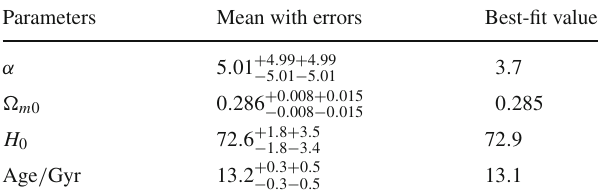
Table 2 This table shows the constraint results on the parameters of DE model with n = 3 using an integrated data base of BAO, JLA and HST